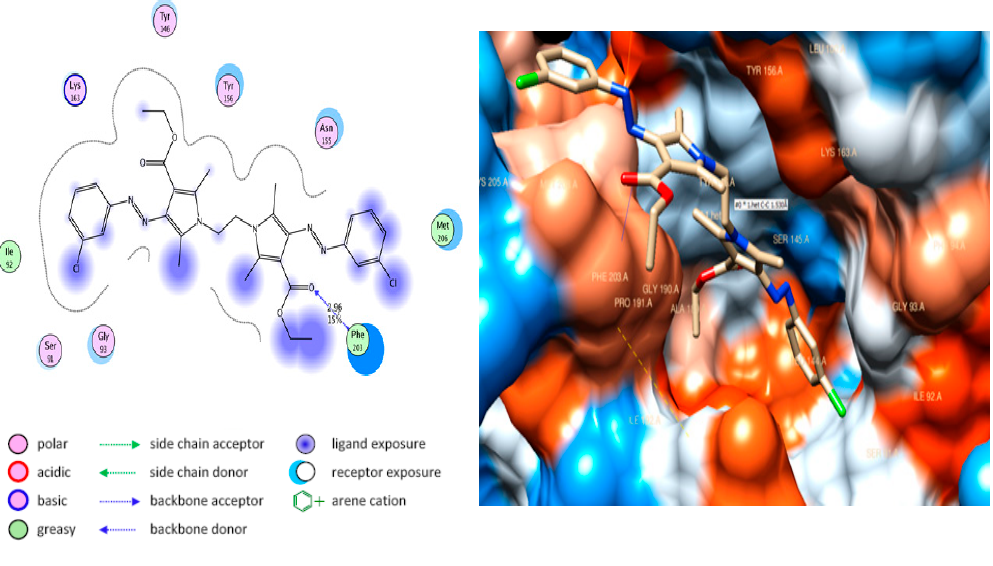
Figure 5. Docking of compound 5e into E. coli Enoyl reductase Enzyme (PDB ID: 1LXC) showing hydrogen bond with Phe203.